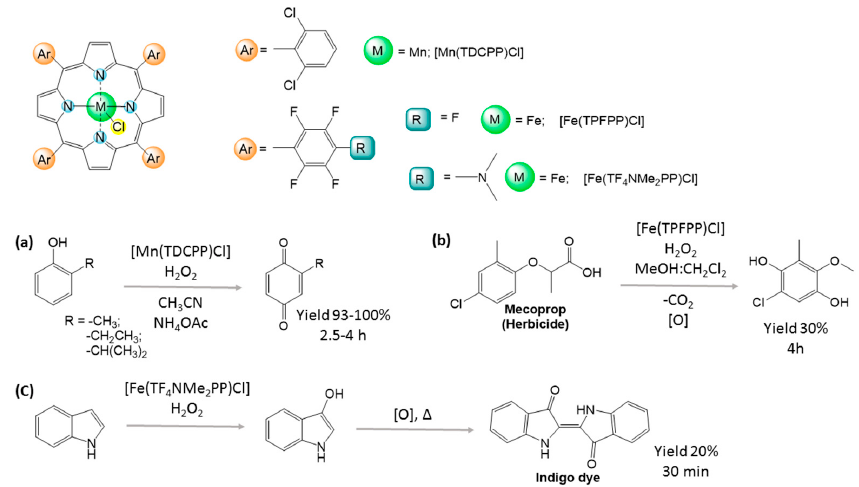
Figure 1. Oxidations of aromatic compounds in the presence of Mn(III) or Fe(III)porphyrins: ( a ) oxidation of alkylphenols; ( b ) oxidation of the herbicide mecoprop; ( c ) production of indigo dye from indene oxidation.